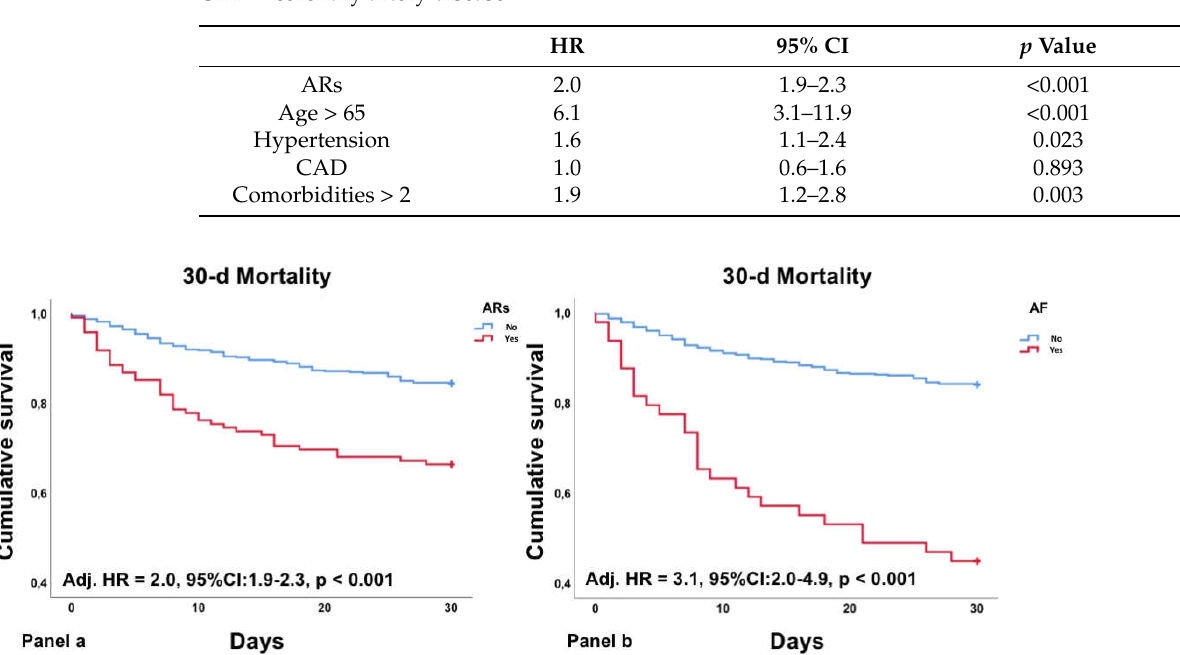
Figure 2. KM curves describing 30-day mortality for ARs (Panel( a )) and AF (Panel ( b )).